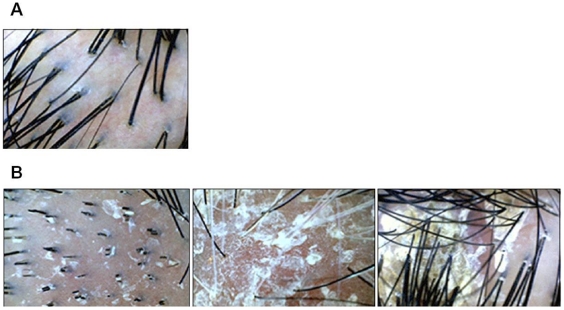
Folliscope images of the sample scalps.(A) Healthy scalp. (B) Dandruff-afflicted scalps.